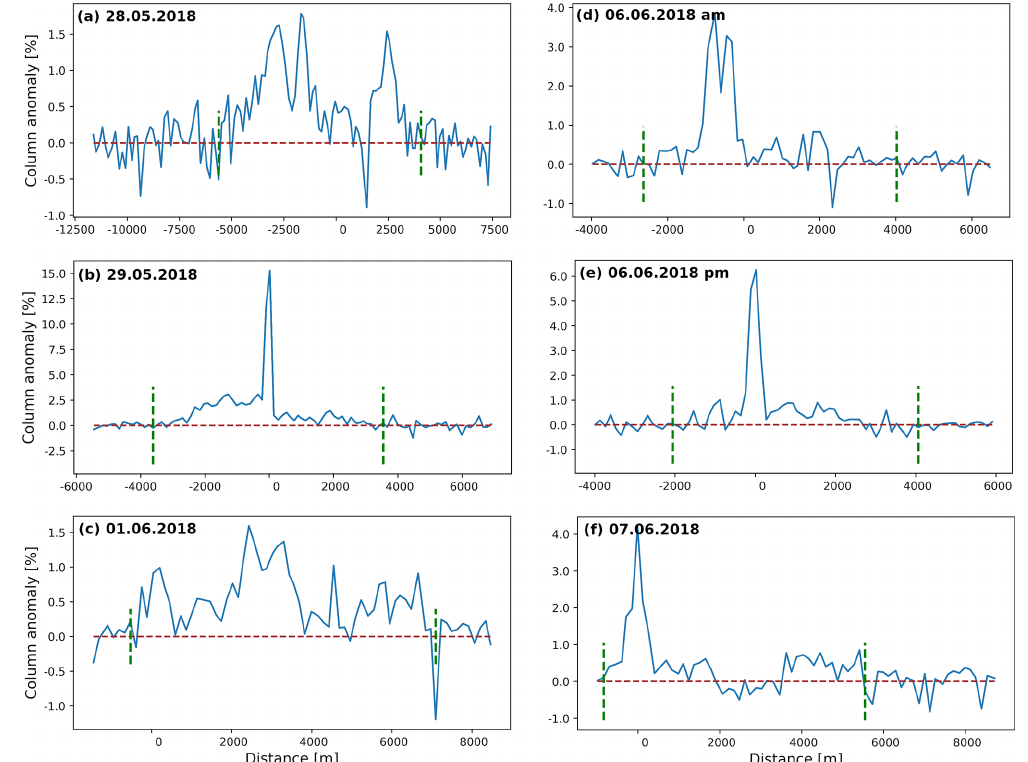
Figure C7. Same as Fig. C1 but for shaft cluster c. A 2D visualization is shown in Fig. C6.